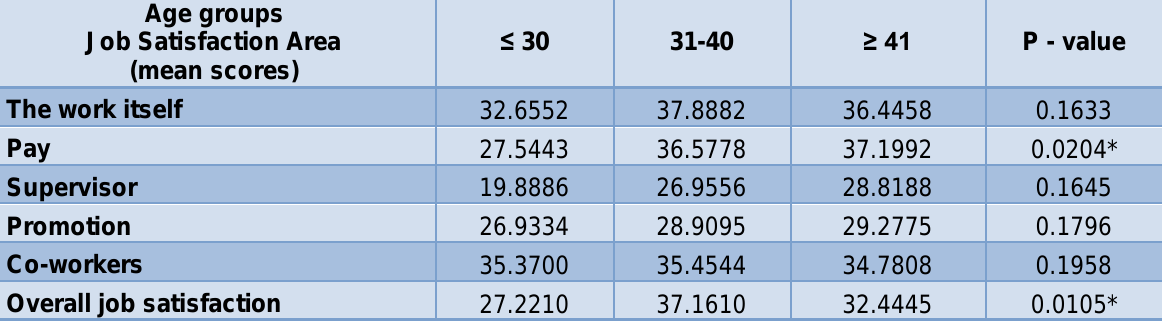
Table 4 Differences in Job satisfaction means based on age (n=100) (One-Way ANOVA) * Denotes significant differences among groups at the 0.05